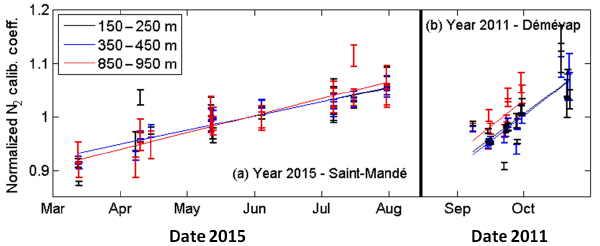
Figure 10. Time series of normalized N 2 calibration coefficients from (a) the Saint-Mandé campaign and (b) the DEMEVAP cam- paign. Three different layers are compared: 150–250, 350–450, and 850-950m. Normalization is done with respect to the mean value for each layer. The smaller number of points for the higher layer in the case of DEMEVAP is due to removal of measurements with Figure 11. Comparison of WVMR measurements from lidar and large standard errors. PTU during the Saint-Mandé campaign: (a) WVMR from lidar from nine different layers (color lines) and PTU (black line) and (b) WVMR difference (lidar – PTU). The lidar measurements were corrected beforehand for a linear drift with N 2 calibration mea- Table 2. Comparison of the stability of the N 2 Calibration coeffi- surements and adjusted to absolute WVMR using the PTU mea- cients for the Saint-Mandé and DEMEVAP campaigns in three dif- surements from 12 March 2015. The nine different layers start at a ferent layers. The slope is estimated by a linear least squares regres- height of 33.75m and have increasing widths from 1 to 9 × 7.5m sion. The last column represents the dispersion (1- σ ) obtained after (with colors going from blue to red). The x axis refers to lidar pro- removing the linear trend from the data. file numbers in chronological order (see H 2 O row in Table 1 for correspondence with Slope Dispersion (%month − 1 ) (%) 150–250m Saint-Mandé